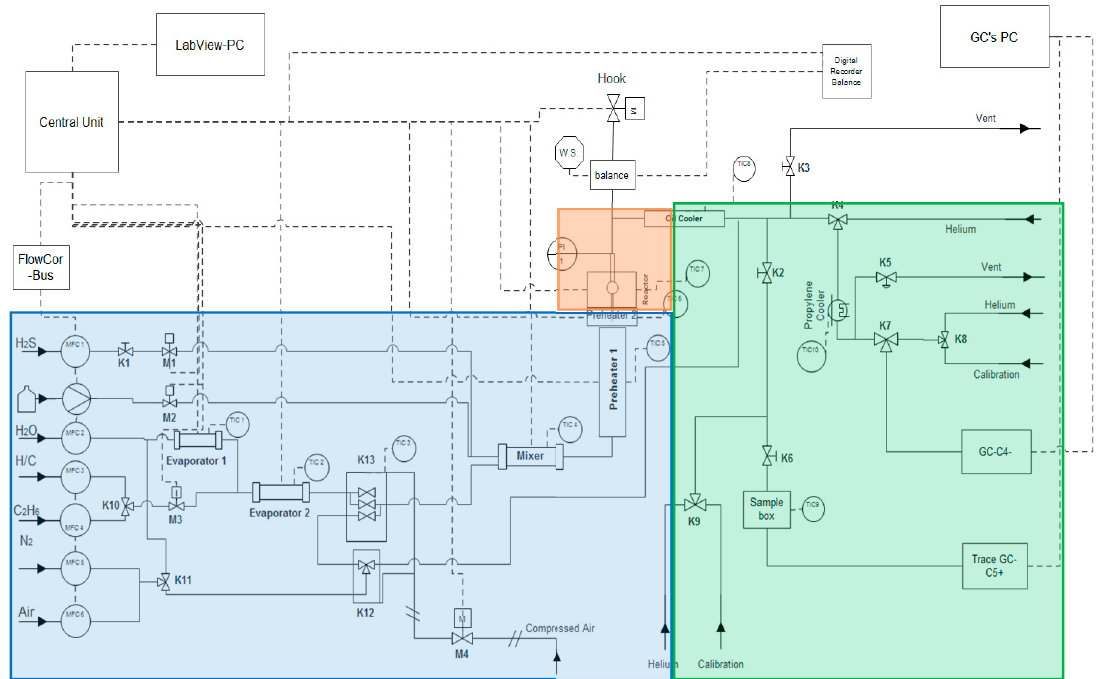
Figure 1. Simplified process flow diagram of the thermogravimetric setup for the study of coke deposition during steam cracking of ethane. (Feed section (blue), Reaction section (red), and Analysis section (green)).